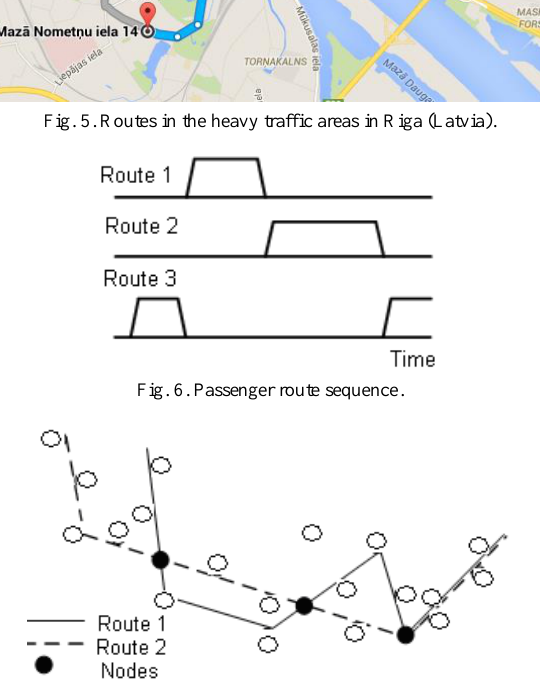
Fig. 7. Fragment of hyper-graph of transport system in